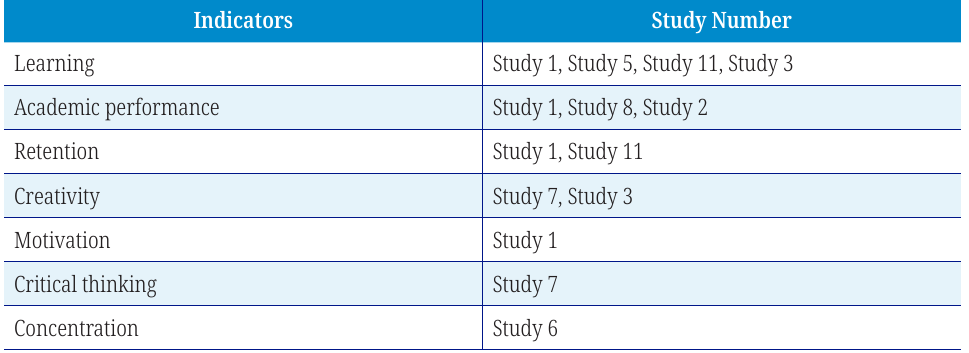
Table 4. Student cognitive engagement